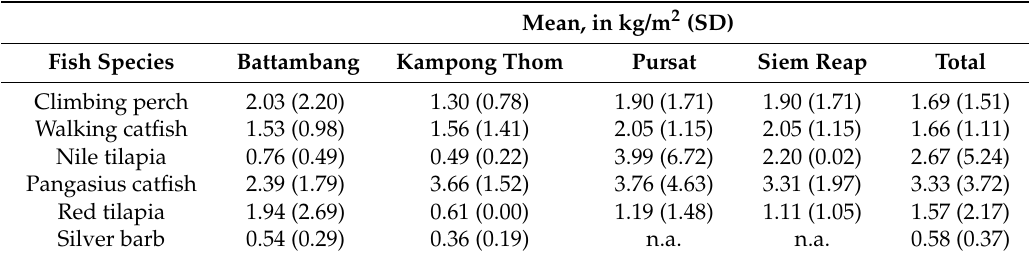
Table 5. Average fish production, by species and province (kg/m 2 ).